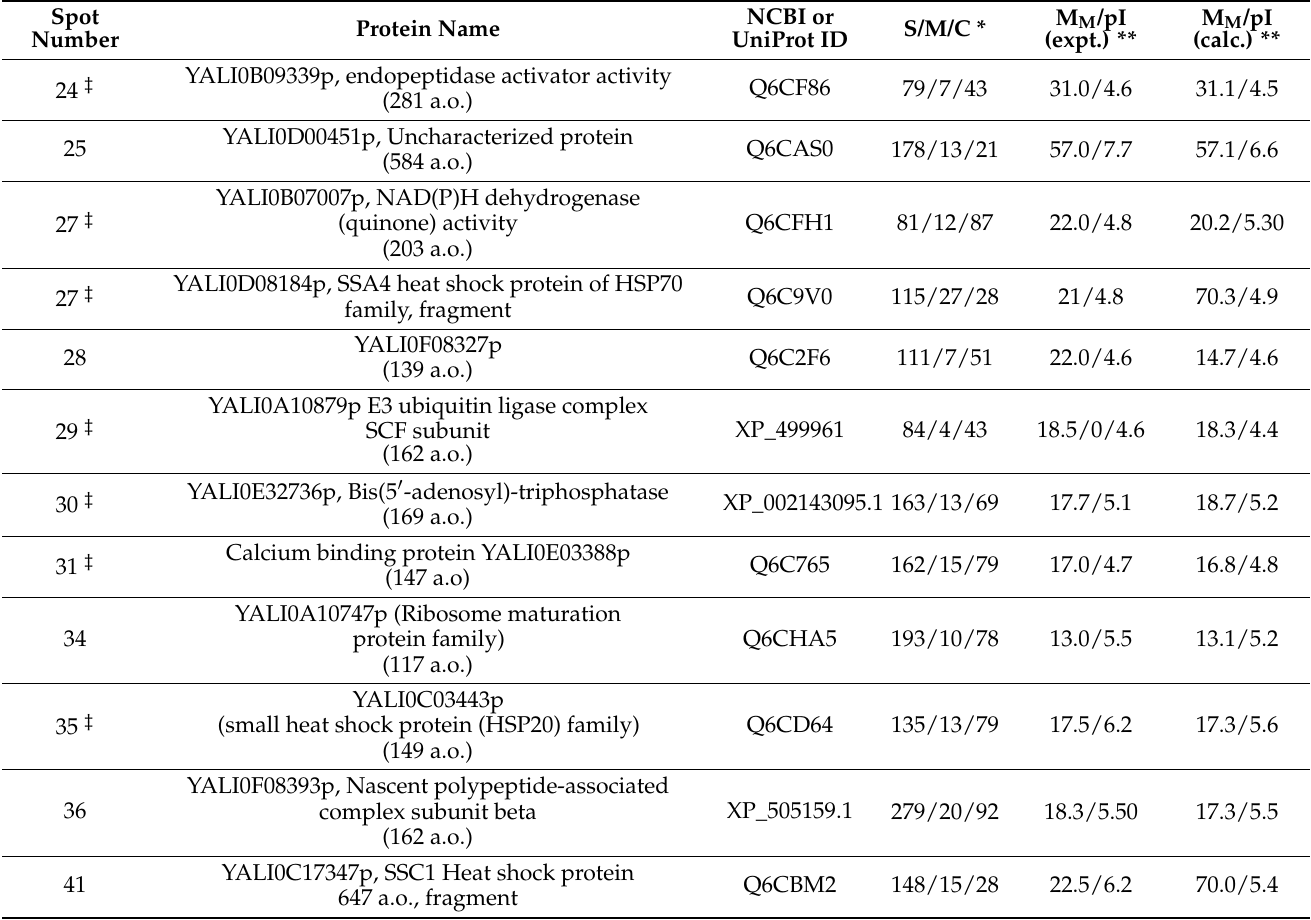
Table 2. The list of induced proteins in response to alkaline stress in the Y. lipolytica yeast using mass spectrometry (MALDI-TOF MS and MS/MS) under alkaline